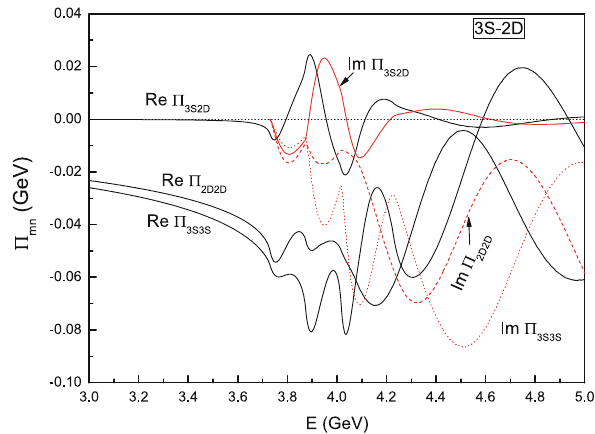
Fig. 2 Real and imaginary parts of (cid:6) mn in 3 S − 2 D sector